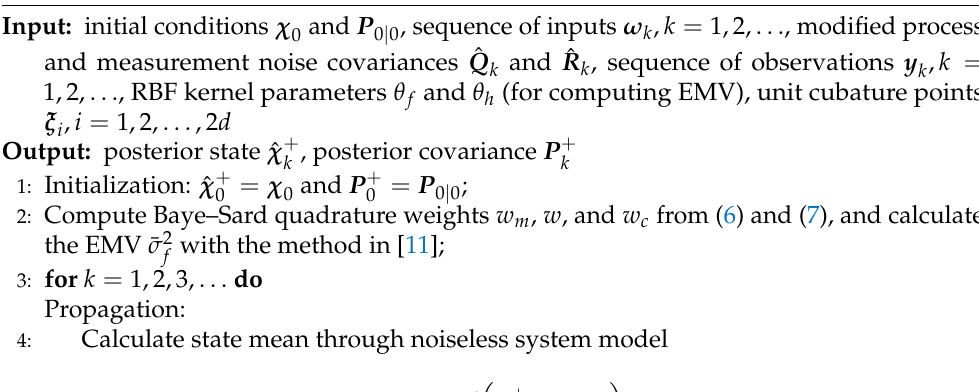
Algorithm 2 Bayes–Sard cubature Kalman filter